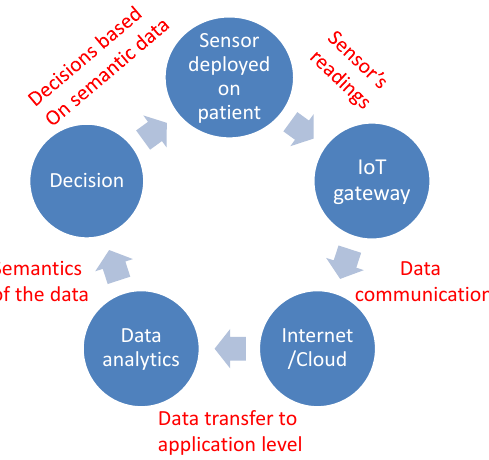
Figure 1. Flow diagram for FoG detection with IoT.